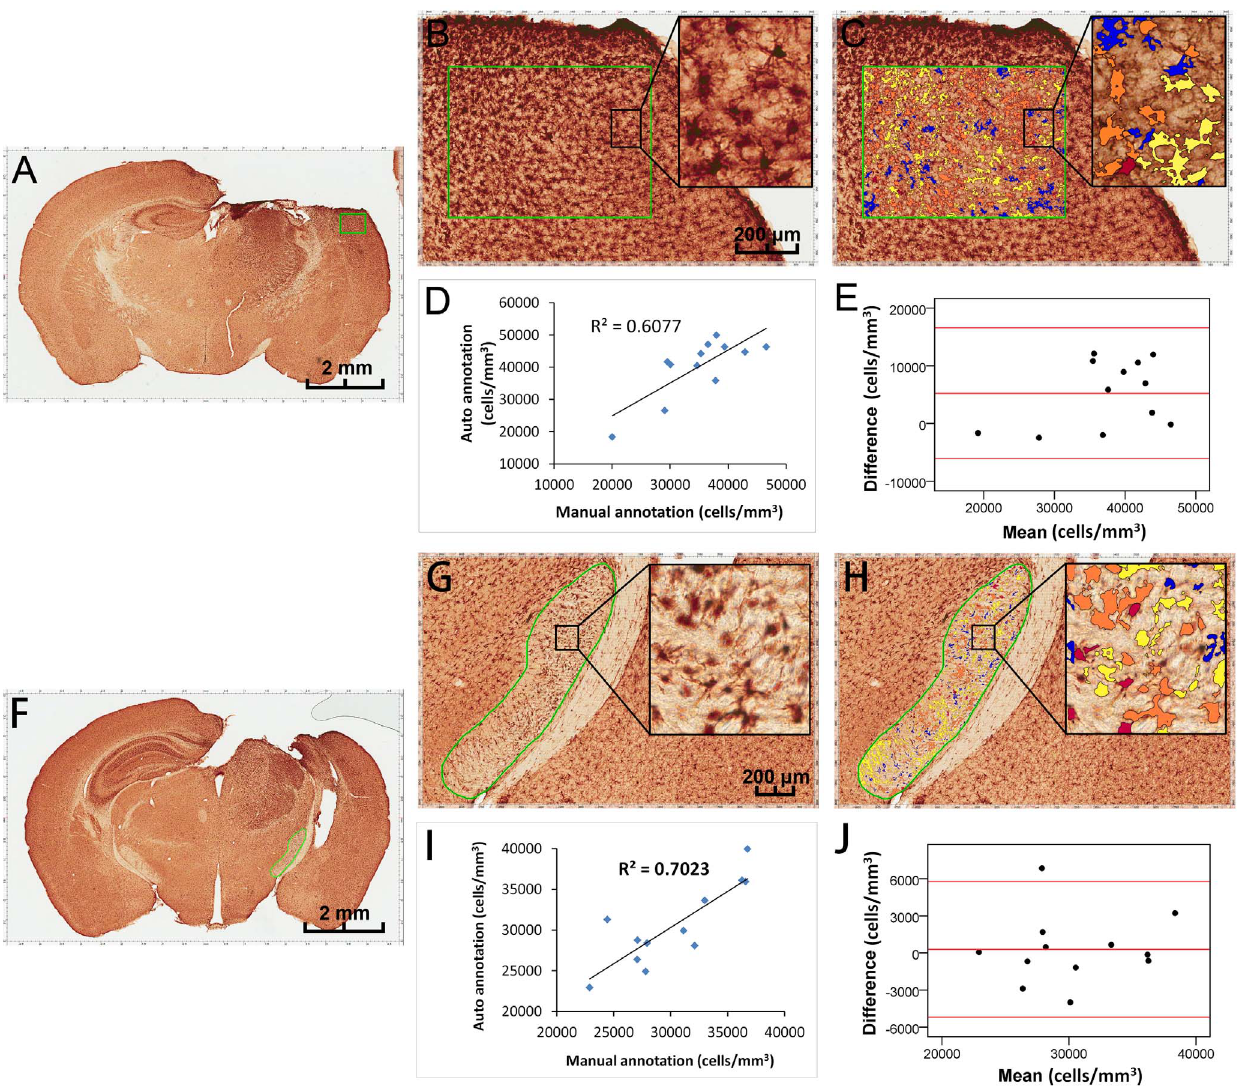
Figure 3. Comparison of the manual and automated annotations of microglial cell density in CCI sections. Iba-1 IHC staining was performed on the brain sections of mice subjected to CCI. A 640 6 480 m m 2 subregion at the peri-lesion cortex at the section of Bregma 2 1.14 mm and the cerebral peduncle at the section of Bregma 2 2.10 mm were used as two ROIs (green outline, A and F ). The Iba-1 positive microglia within the cortex have a bushy morphology with thick, densely labeled processes and large cell bodies ( B , embedded). The algorithm produced the mark-up images ( C ), where the red, orange, and yellow pixels visualize immunoreactivity-positive cells (strong, moderate, and weak intensity, respectively), whereas blue pixels depict immunoreactivity-negative cells. Pearson correlation coefficient ( D ) and Bland-Altman difference plots ( E ) showed a high degree of concordance (R=0.756, P=0.004, n=12) and strong agreement between the manual and automated annotations of microglial cell density in cortex. However, the morphology of active microglia in the cerebral peduncle was different to that in cortex, and showed an amoeboid appearance with fewer processes ( G , embedded). With adjustment of the algorithm parameters ( H ), Pearson correlation coefficient ( I ) and Bland- Altman difference plots ( J ) showed high a degree of concordance (R=0.838, P=0.001, n=12) and strong agreement between the manual and automated annotations of microglial cell density in cerebral peduncle. A, F: scale bar=2 mm; B, C, G, H: scale bar=200 m m.